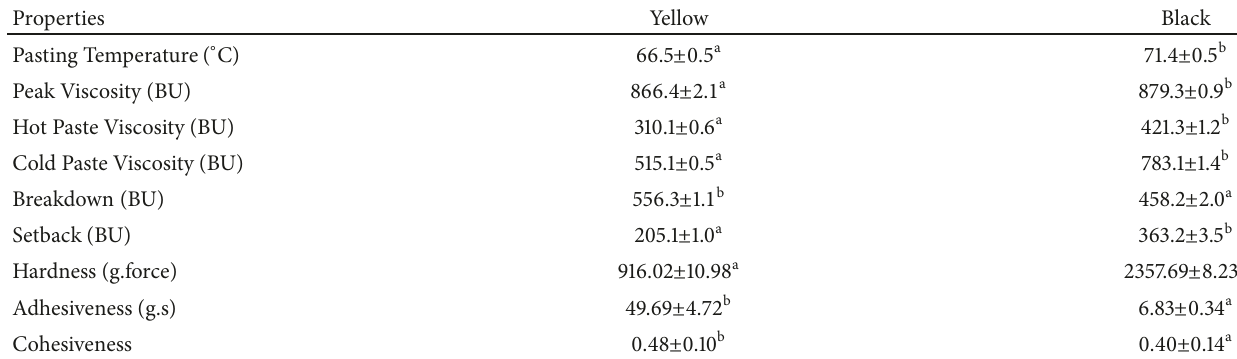
Table 3: Tigernut starch pasting and gel texture properties.